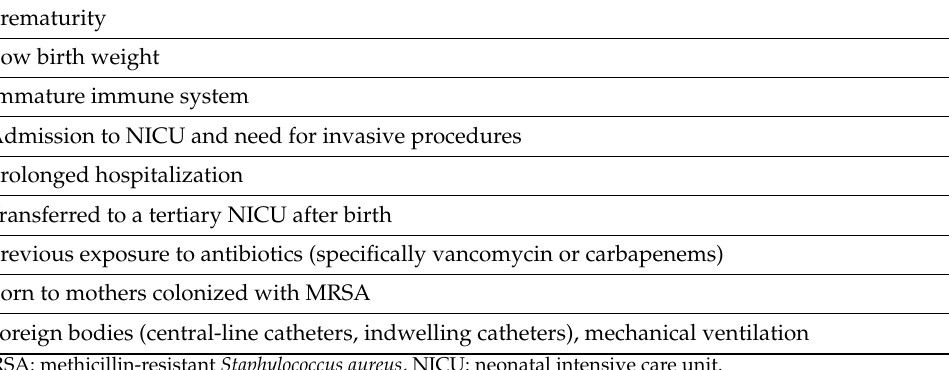
Table 1. Main risk factors for neonatal